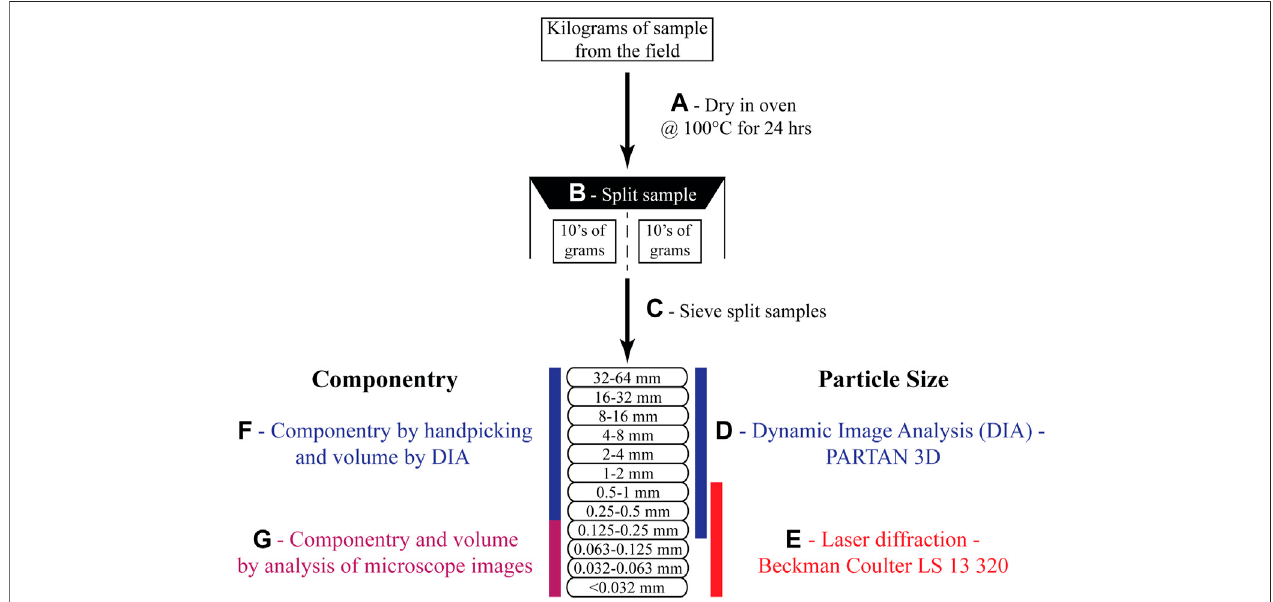
FIGURE2| Summaryofthework fl owstepsofourstudy. (A) Allsamplescollectedfromthe fi eldweredriedinanovenat100 ° Cfor24 htoremoveadsorbedwater. (B) Samples were then split into workable aliquots of tens of grams each. (C) Split samples were manually sieved into twelve discrete size fractions. (D) Dynamic image analysis was performed on size fractions 0.125 – 0.25 mm and larger. (E) Laser diffraction analysis was performed on size fractions 0.5 – 1 mm and smaller. (F) Componentry for particles in size fractions 0.25 – 0.5 mm and larger was determined via handpicking under a stereo microscope and analyzing particle volumes using DIA. (G) Componentry and volume of particles in size fractions 0.125 – 0.25 mm and smaller were determined via microscope images.